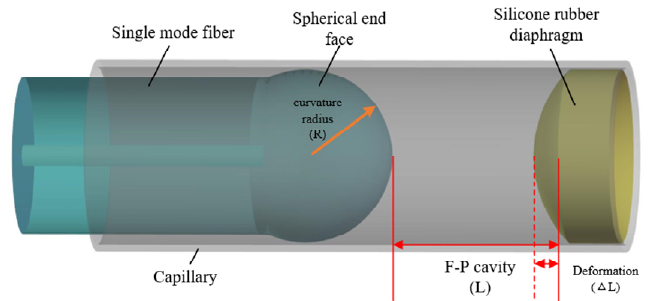
Figure 3. Structure diagram of the proposed sensor based on a spherical end face.